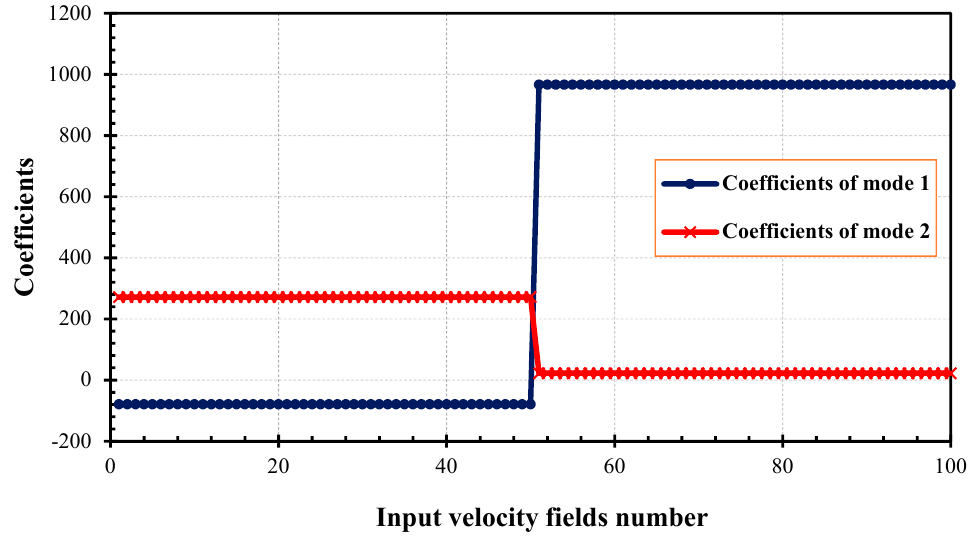
Figure 8. Coefficients of first two POD modes for all 100 input velocity vector fields